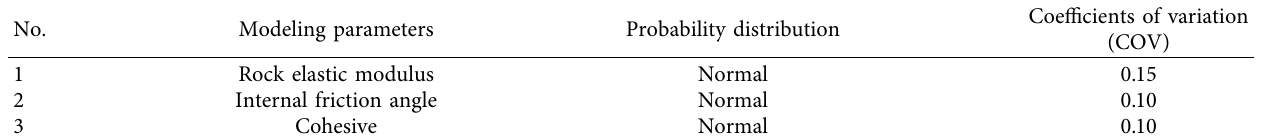
Figure 4: Schematic diagram of numerical modeling of the open-pit mine slope case along the A 1 profle. Table 2: Distribution characteristics of slope modeling parameters.